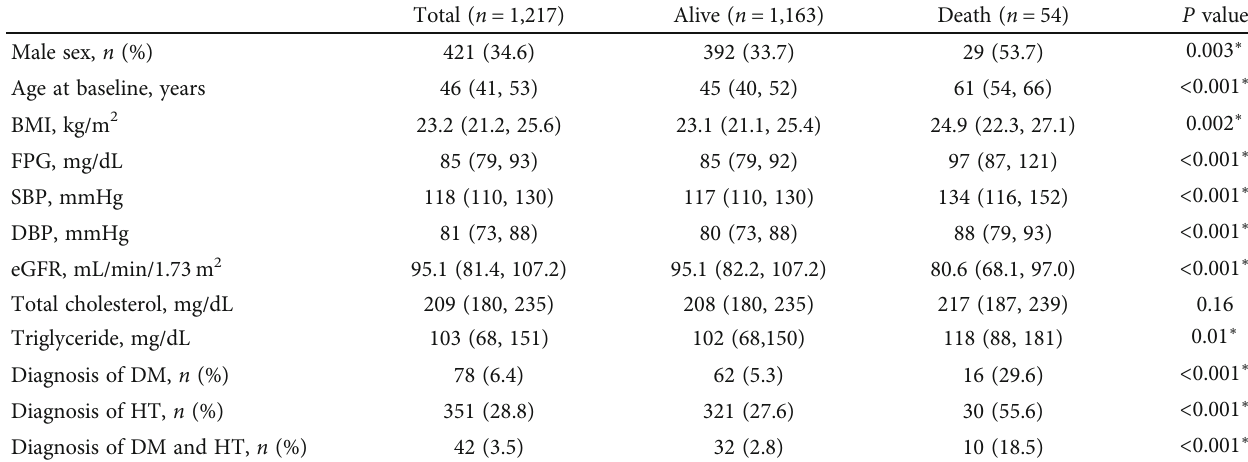
Table 1: Baseline characteristics of study participants according to 10-year vital